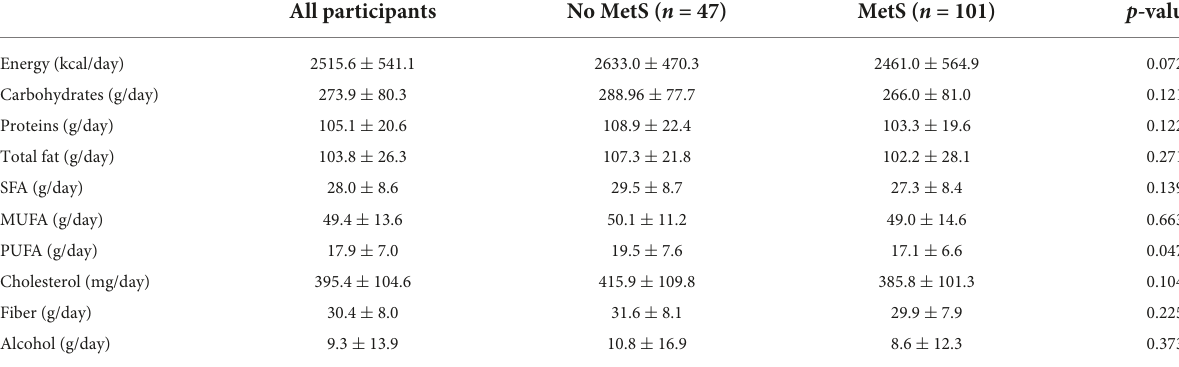
TABLE 2 Dietary intake for all participants and according to MetS at baseline 1